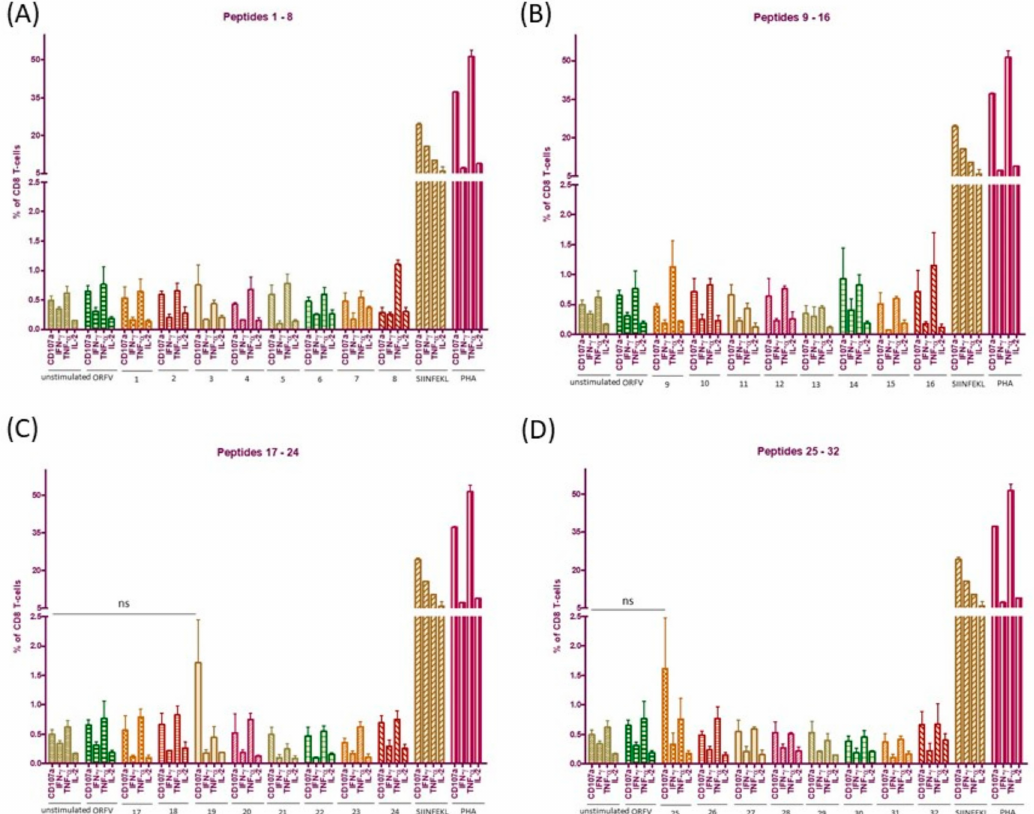
Figure 4. CD8 + T cell responses to the individual ORFV-derived peptides by intracellular cytokine staining (ICS) in ORFV immunized mice. H-2K b C57BL / 6 mice ( n = 6) were immunized twice with V12-Ova-D12-GFP or control ORFV by i.m. route. One week after the second administration specific cytotoxic T lymphocyte responses to the individual ORFV-derived peptides within pooled